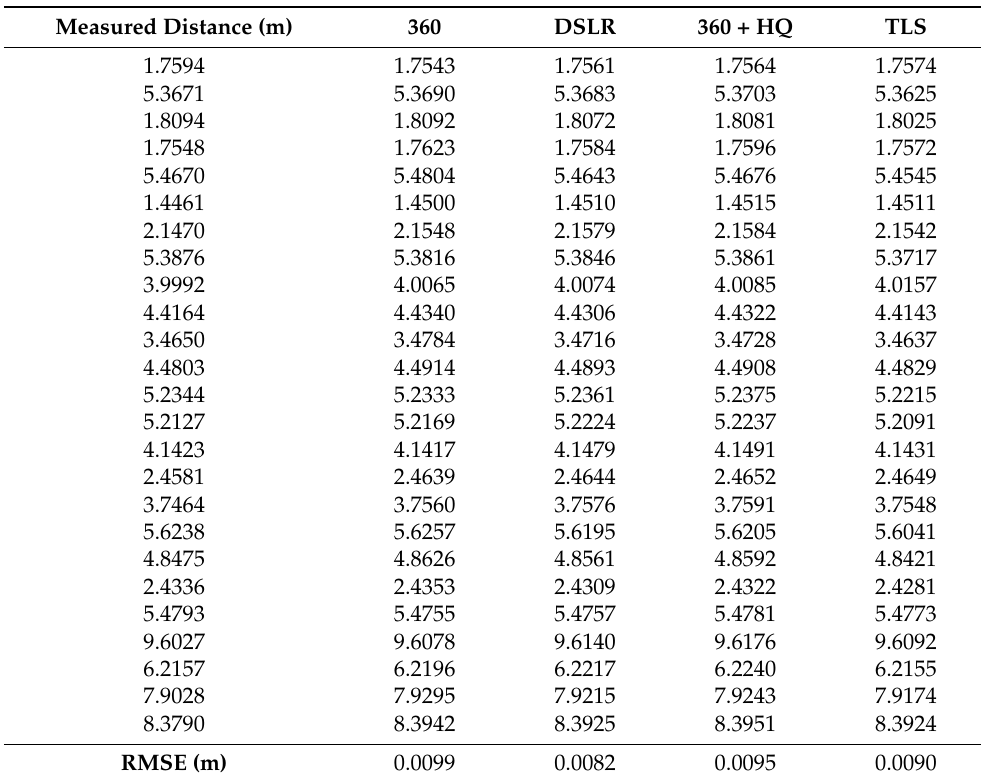
Table 4. Measured and calculated control distances and the RMSE.